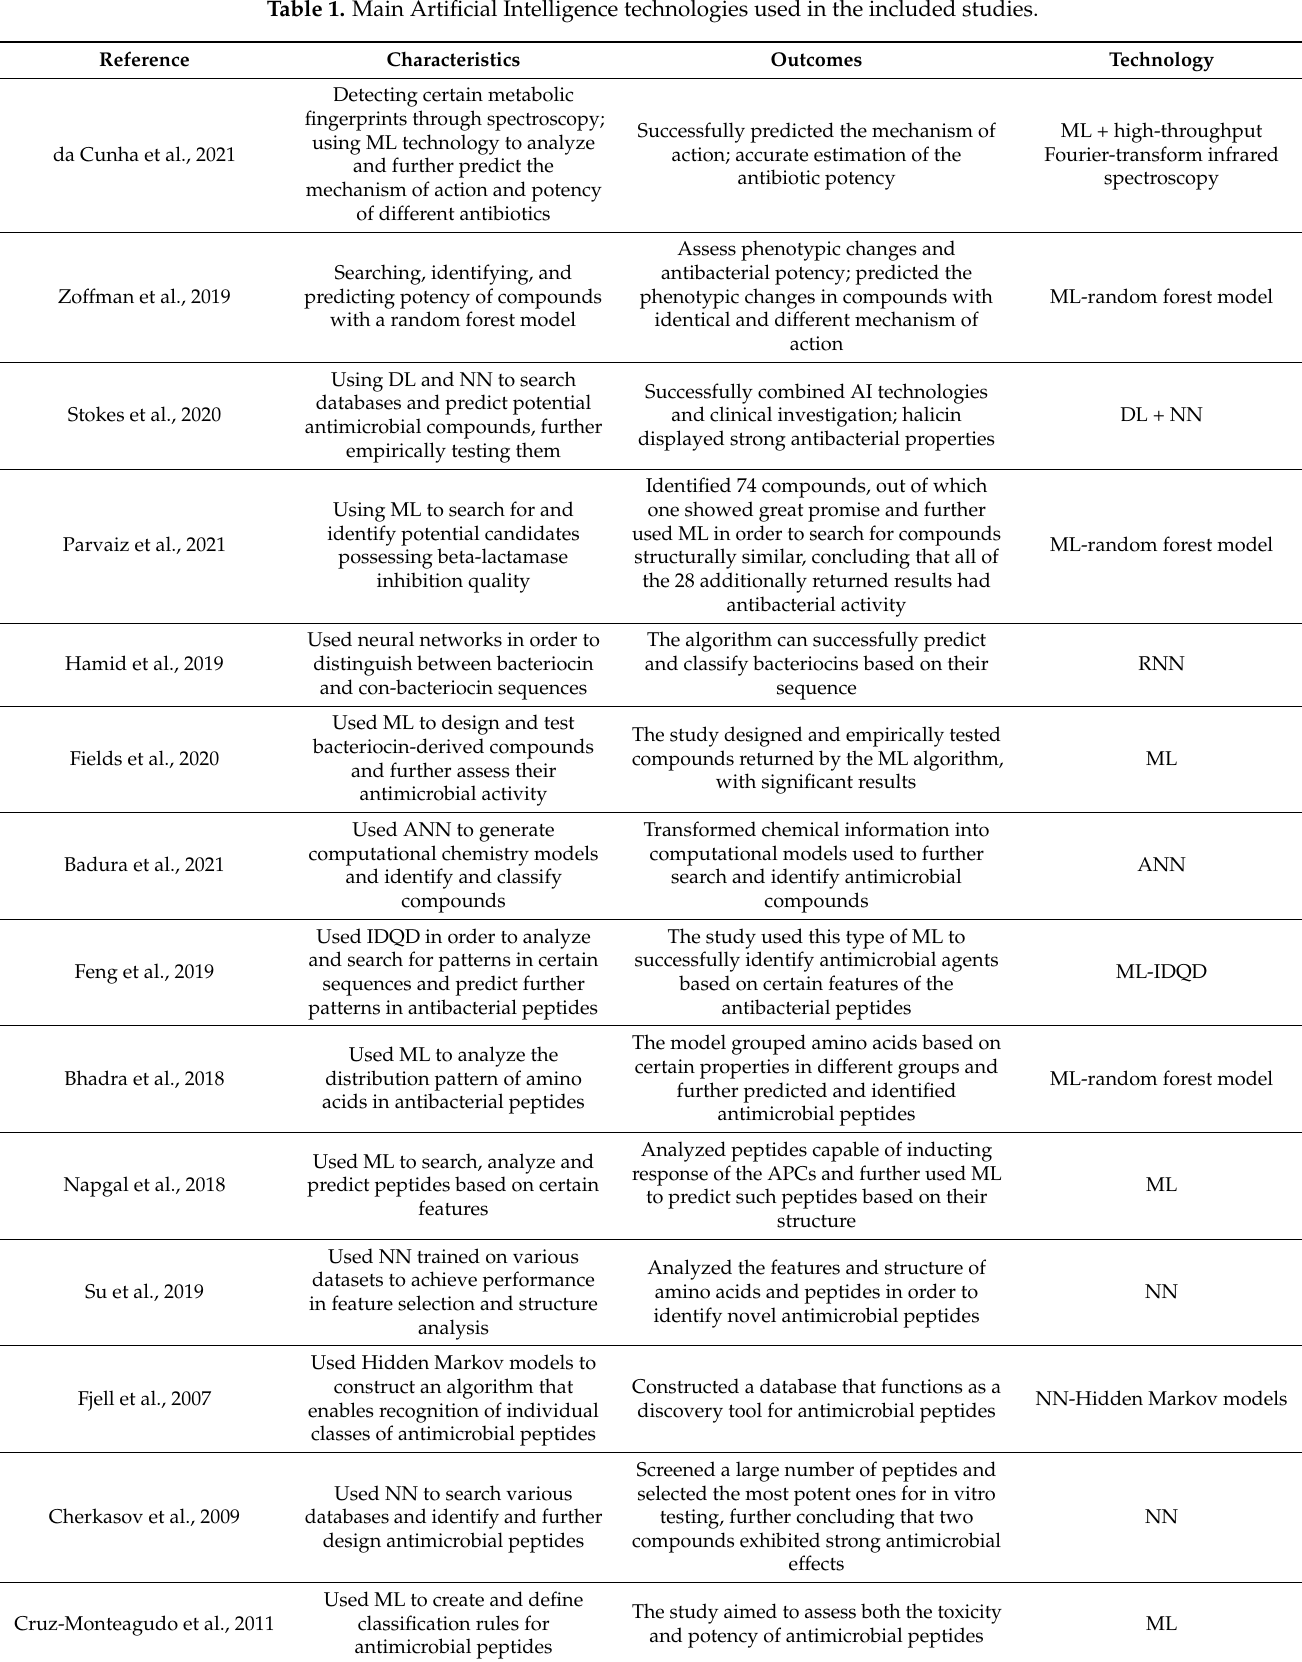
Table 1. Main Artificial Intelligence technologies used in the included